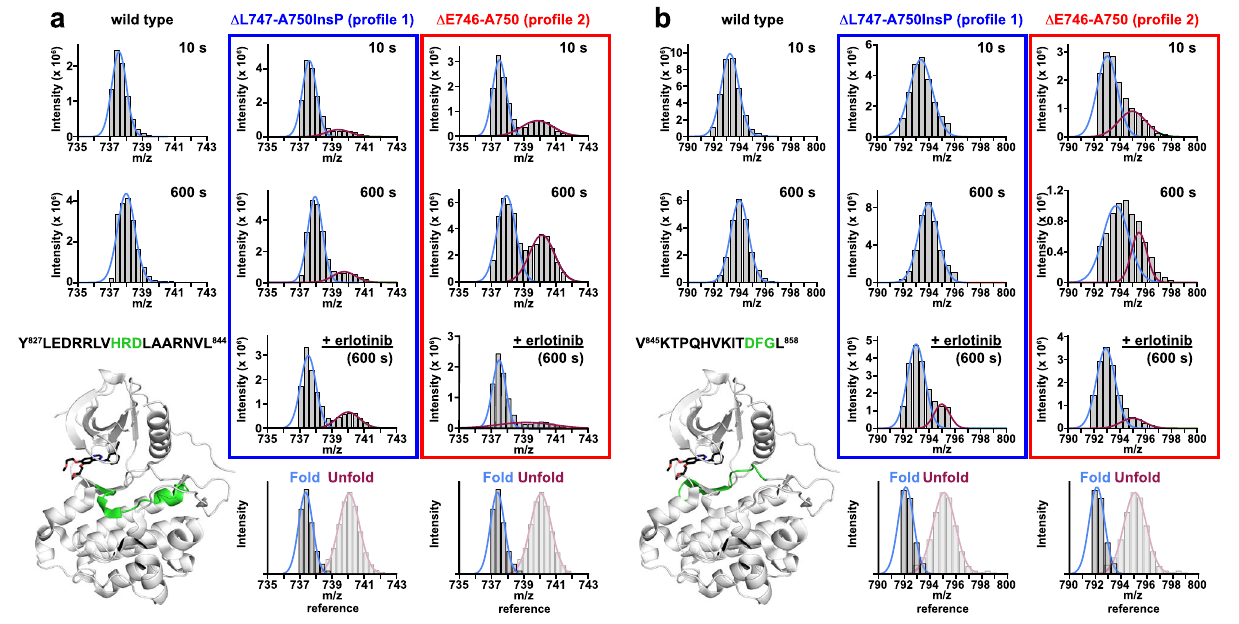
Fig. 6 | HRD and DFG motif peptides of pro fi le 2 variants are in unfolded regions. a Mass spectra of a triply charged peptide (MH + =2209.2312Da)